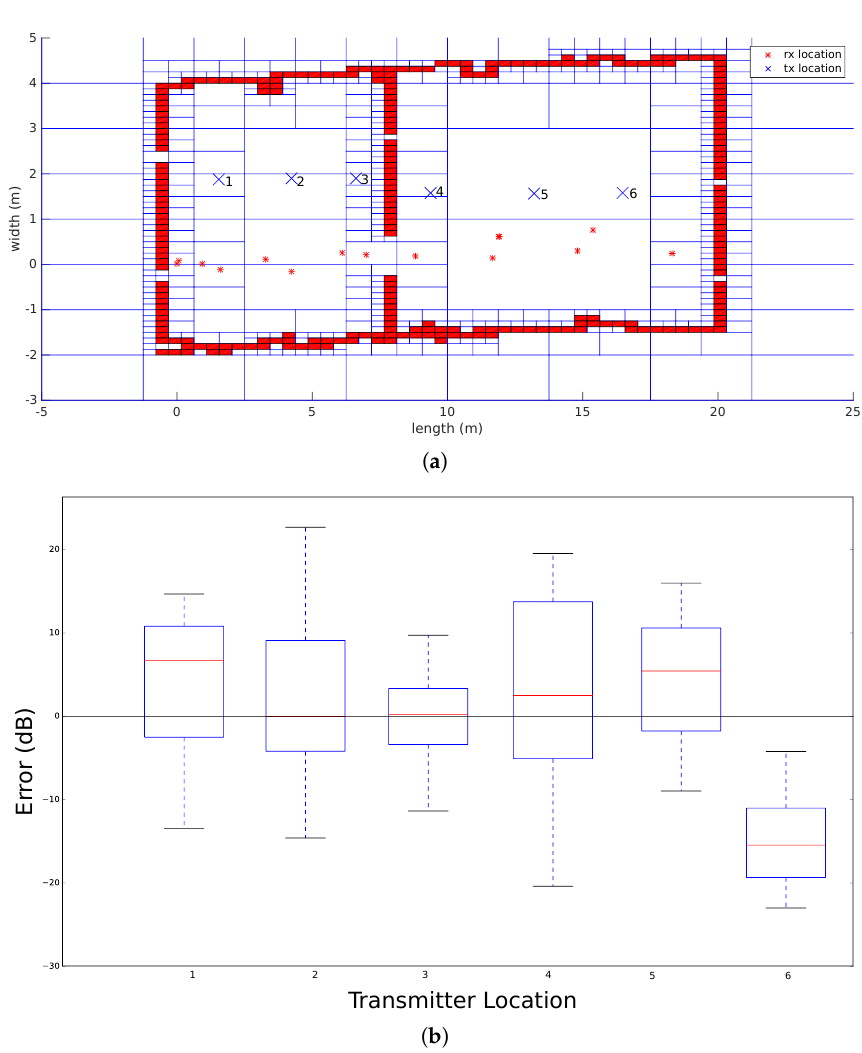
Figure 21. Office environment model 1. ( a ) environment model with transmitter and receiver locations; ( b ) validation of the different